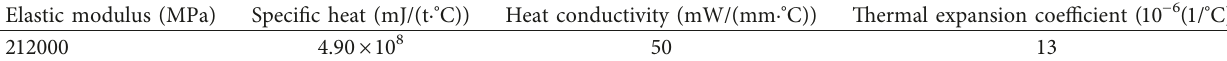
Table 4: Thermophysical properties of the brake backplate